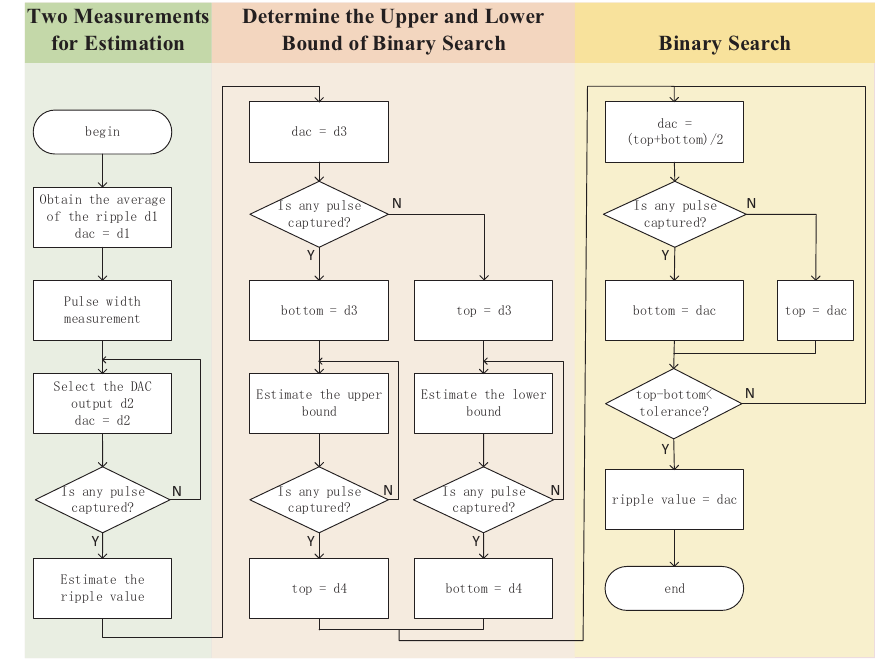
Figure 5. Flowchart of the proposed